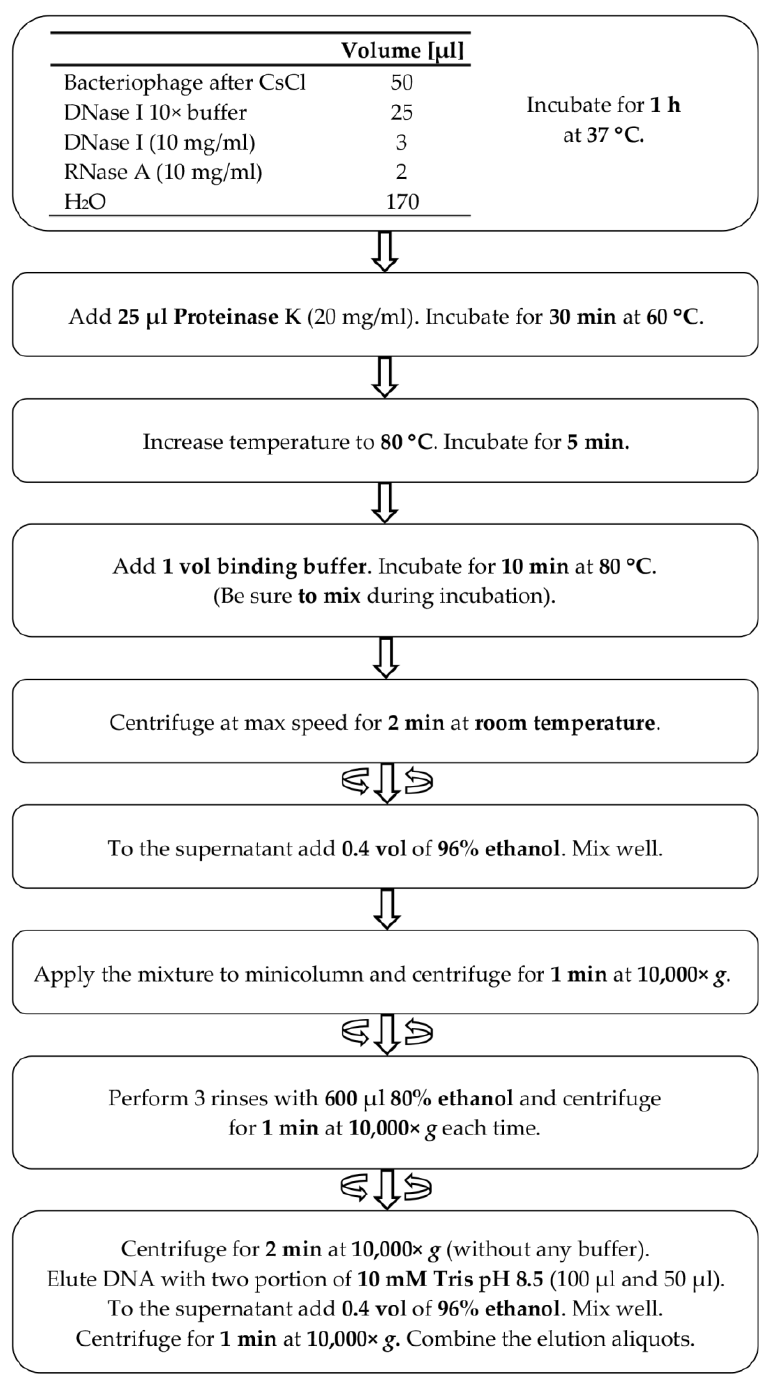
Figure 1. Scheme illustrating the method for isolation of bacteriophage genomic DNA, free of bac- teriophage particles bacteriophage